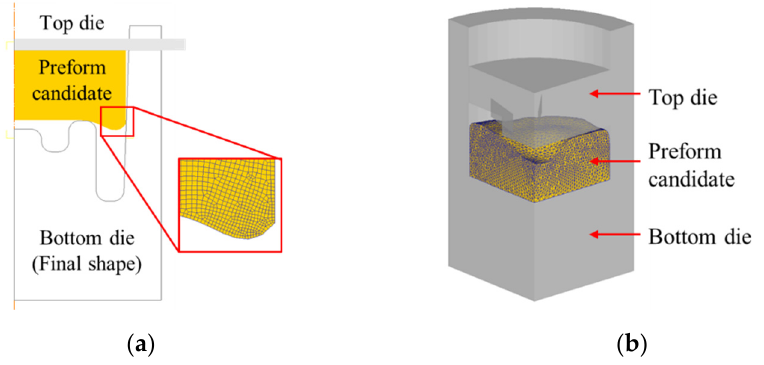
Figure A3. The numerical simulation model for ( a ) 2D axis-symmetric forging and ( b ) 3D forging considering ¼ of the geometry.